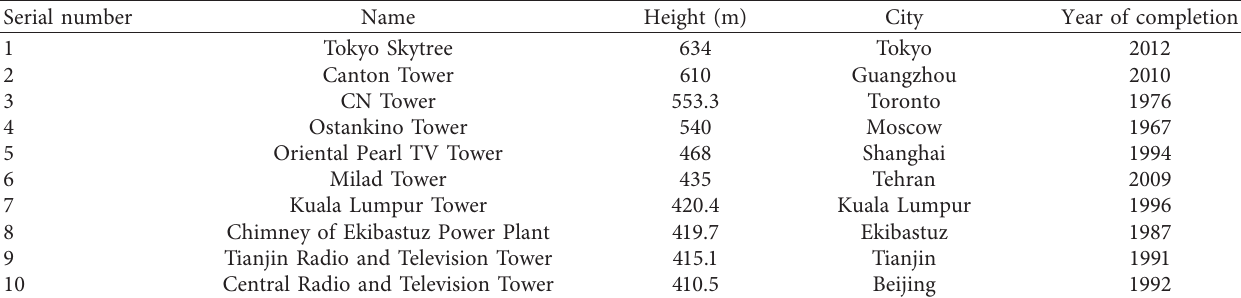
Table 2: The world’s top ten tallest structures (as of June